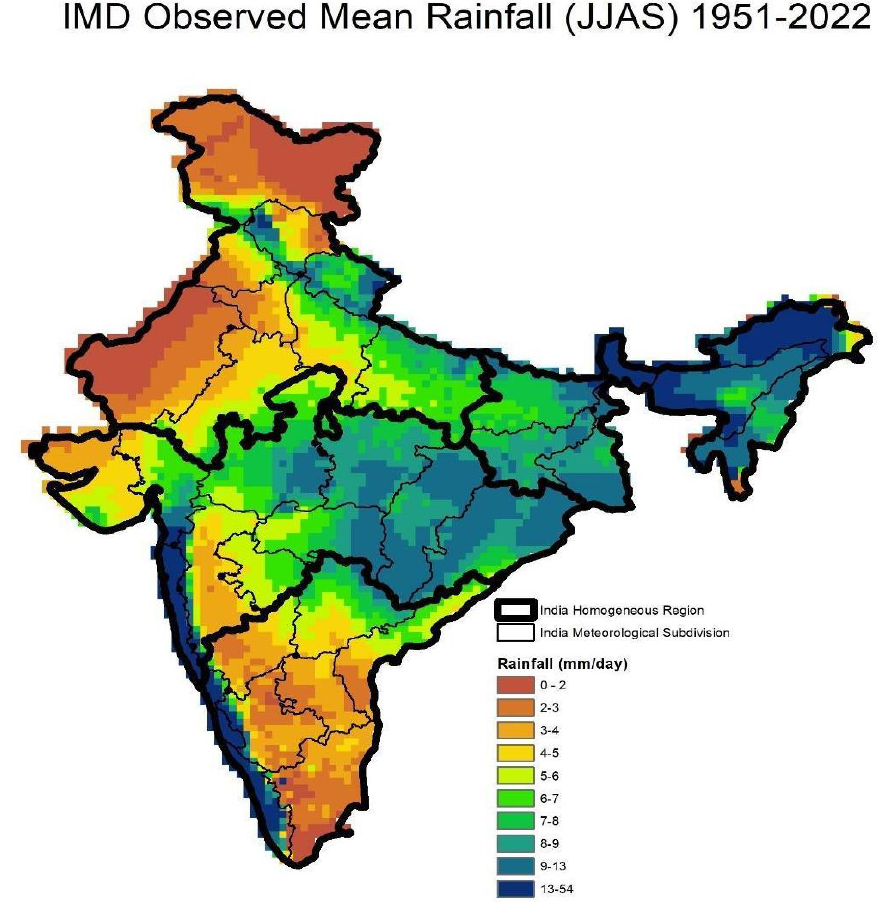
Figure 4. India Meteorological Department (IMD) Observed Rainfall (June to September) 1951 – 2022.